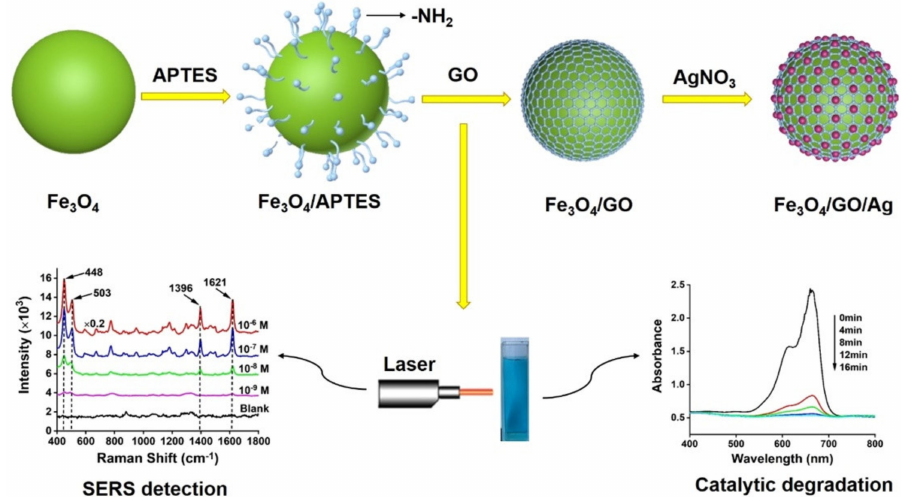
Figure 8. Illustration of the fabrication of Fe 3 O 4 /GO/Ag composite microspheres